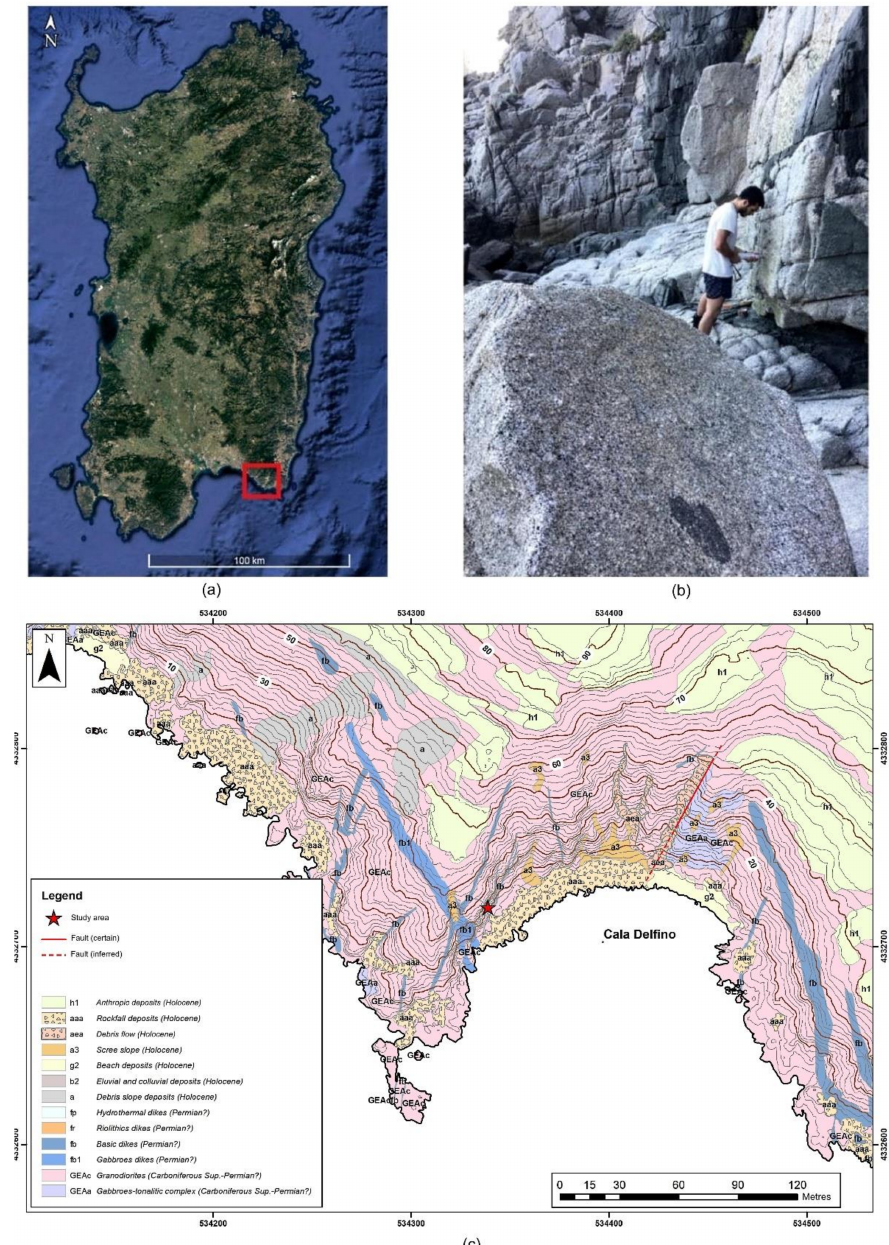
Figure 1. ( a ) Location of the study area; ( b ) rebound hammer test; ( c ) geological map. The plutonic rocks belong to the Geremeas intrusive Unit (GEA) [62]. Coarse-grained, equigranular to moderately inequigranular Granodiorites (GEAc) are present, with medium-fine grained, greenish-grey enclaves of gabbro-tonalitic masses (GEAa). The dikes crosscutting the unit are generally vertical, 1–10 m thick, NNW- and, subordinately, NE-trending. They are basaltic to andesitic dikes (fb), grey-green to blackish, with aphanitic to microcrystalline or porphyritic structure for phenocrysts of feldspar and/or amphibole, and gabbroid dikes (fb1), dark grey, with microgranular structure for plagioclase, pyroxene and quartz. The stabilised slope deposits ( a ) consist of debris accumulations of angular clasts, locally with matrix, at times partially compacted and stabilised. Eluvial-colluvial deposits (b2) are made of debris in a fine matrix, sometimes intercalated with more or less evolved soils, organic-enriched. Beach deposits (g2) are made of current sands, gravels and pebbles with local remains of Posidonia oceanica. The active slope deposits (a3) are still evolving, chaotic accumulations of incoherent clasts in a finer matrix, mainly of weathered granitoids. Rockfall deposits (aaa) consist of dm- to m-sized angular blocks. Debris flow deposits (aea) are unsorted, chaotic angular clasts, blocks, plant remains, with some anthropic material in a fine sandy-silty matrix. Anthropic deposits (h1) from manufactures and filling materials are also